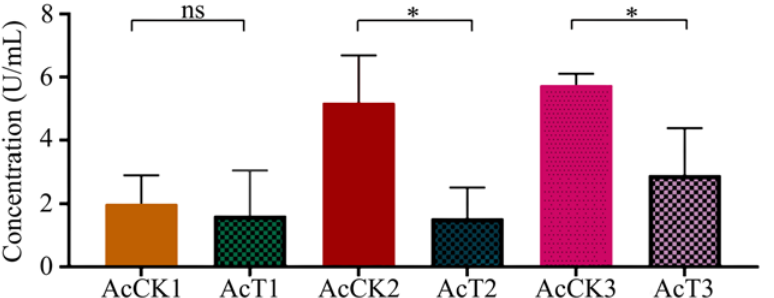
Figure 4. CAT activity in A. cerana 4-, 5-, and 6-day-old larval guts infected by A. apis . The experimental data are shown as mean ± SD and were subjected to Student’s t -tests, ns: p > 0.05, *: p < 0.05. AcCK1, AcCK2, and AcCK3 respectively represent the uninfected 4-, 5-, and 6-day-old larval guts, whereas AcT1, AcT2, and AcT3 respectively represent the A. apis –infected 4-, 5-, and 6-day-old larval guts.